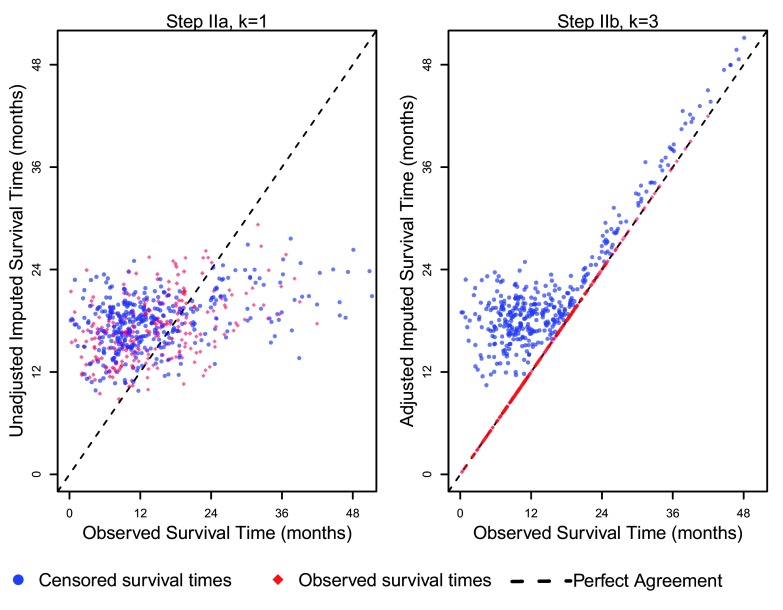
Observed vs. imputed survival times.